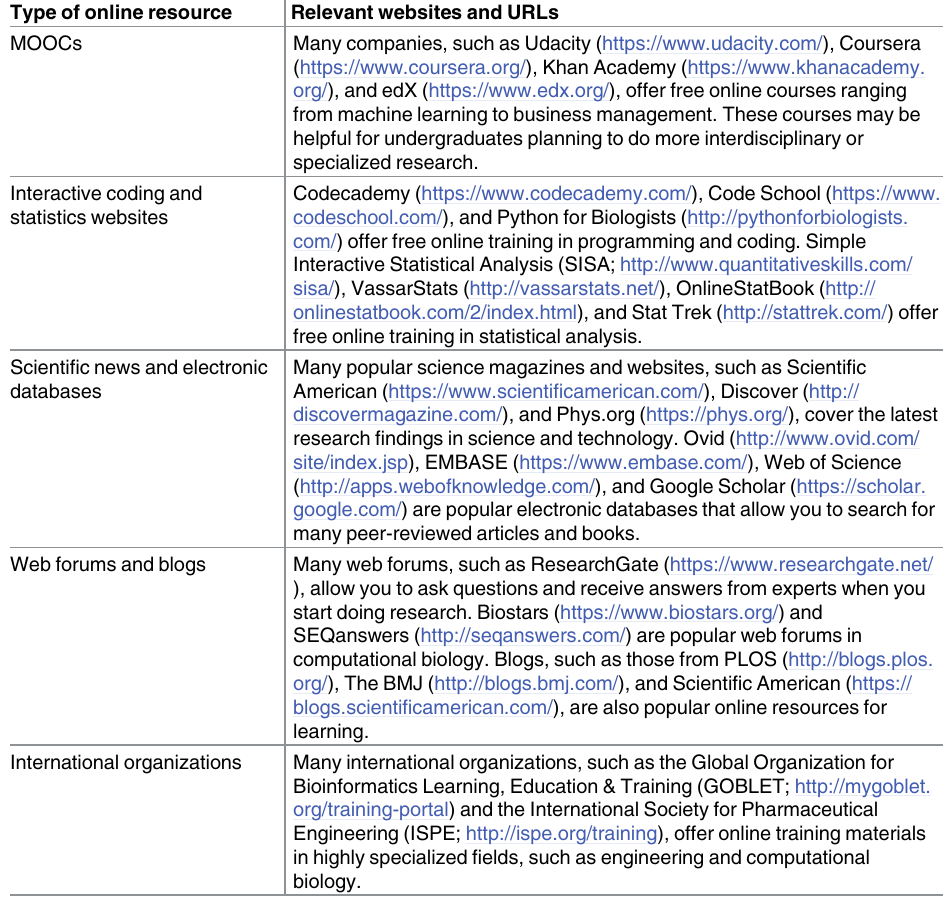
Table 1. Useful online resources for undergraduates in background